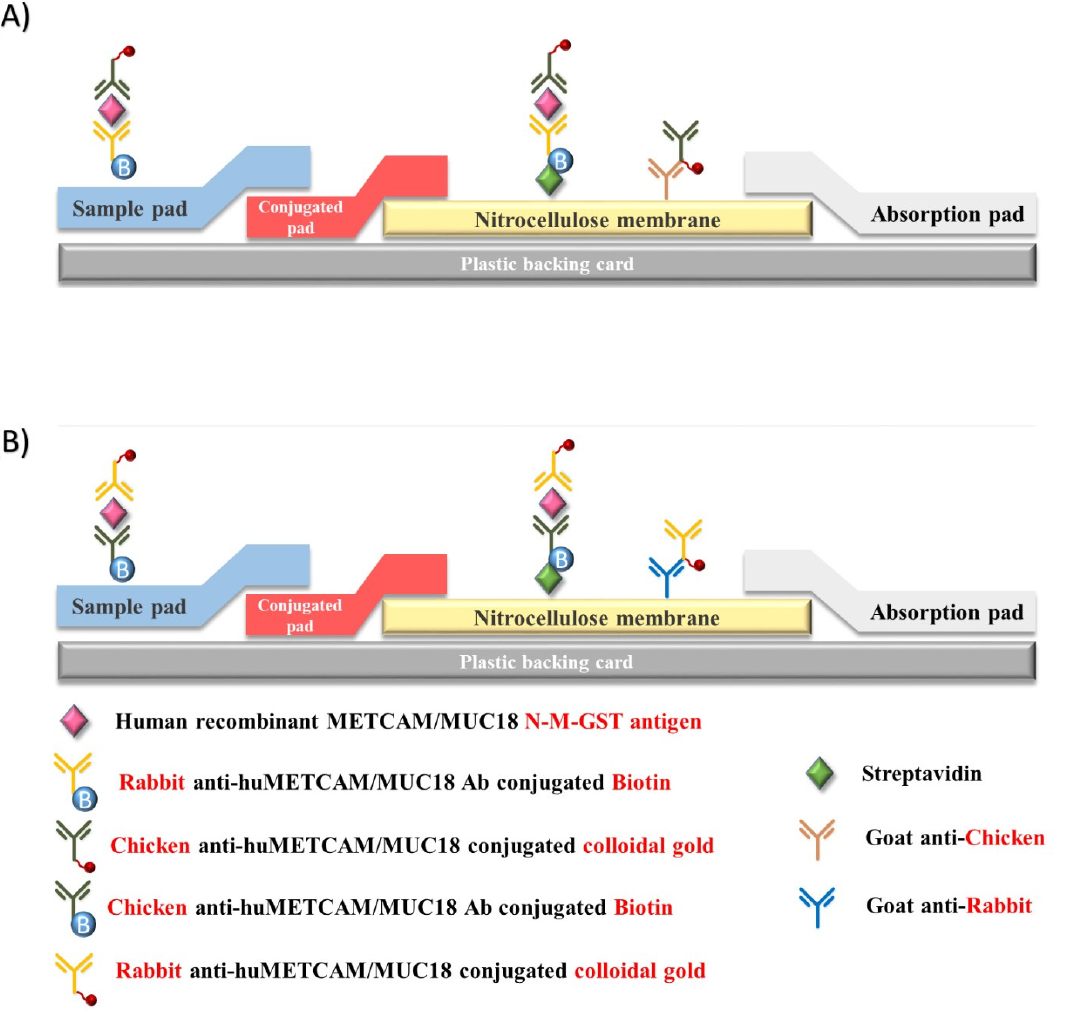
Figure 1. The set-up of modified Lateral Flow Immune Assay (LFIA). LFIA was set up by assembling of the sample pad, the conjugation pad, the nitrocellulose membrane, and the absorption pad on top of a plastic backing card. Streptavidin was printed on the T-line of and goat antibody against primary chicken antibody or rabbit antibody printed on the C-line of the nitrocellulose membrane. ( A ) shows the set-up of modified LFIA by using the first antibody combination (commercial biotinylated rabbit antibody EPP11278 and nano-gold conjugated home-made chicken antibody). ( B ) shows the set-up of modified LFIA by using the second antibody combination (biotinylated home-made chicken antibody and nano-gold conjugated commercial rabbit antibody EPP11278).